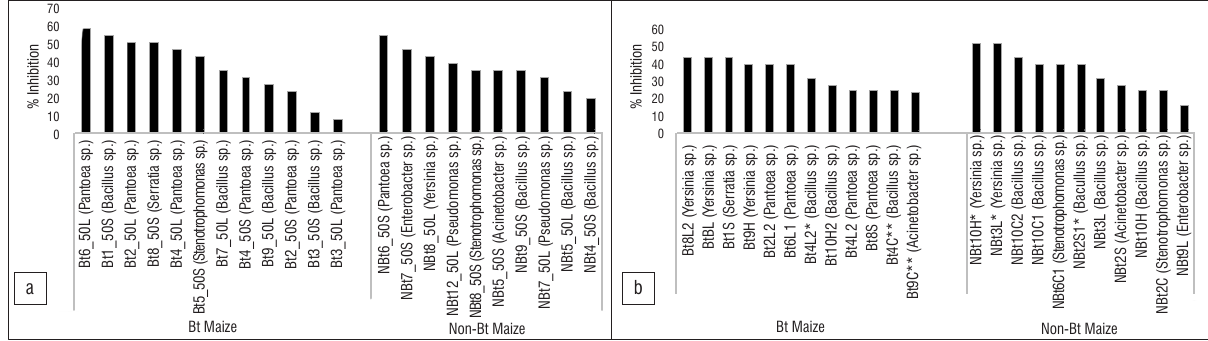
Figure 9: The effect of bacterial isolates on the growth of Fusarium verticillioides 10025 as measured by percentage inhibition of the radial growth of the colony: (a) Isolates from 50-day-old maize and (b) isolates from 90-day-old